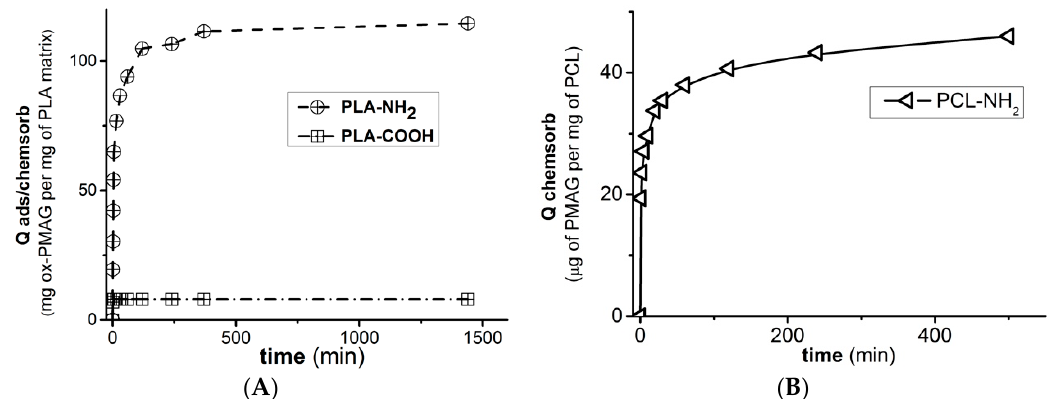
Figure 3. Kinetic curves of ox-PMAG adsorption: ( A ) Carboxylated and aminated PLA matrix surface, ( B ) aminated PCL matrix surface. Conditions: 0.01 M sodium borate buffer solution, pH 8.5, 25 °C, 300 rpm, [ox-PMAG] = 1 mg/mL.